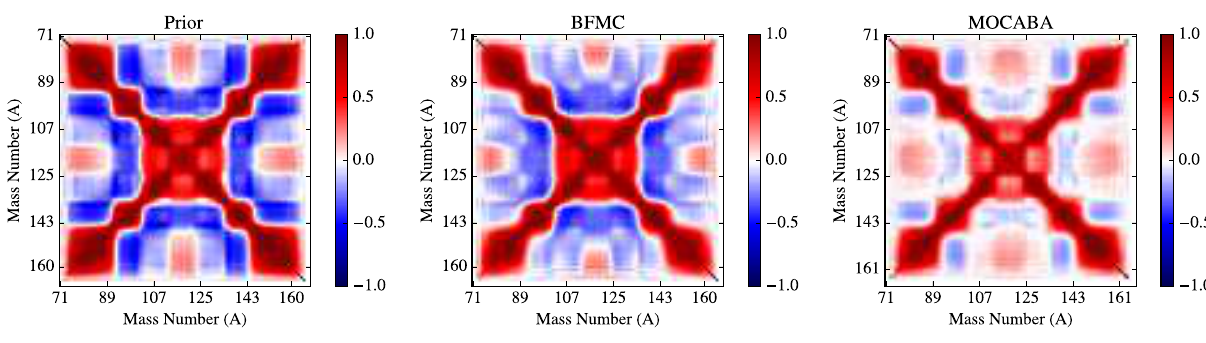
Fig. 7. Relative differences in the means and relative standard deviations of Pu-239 independent FYs.